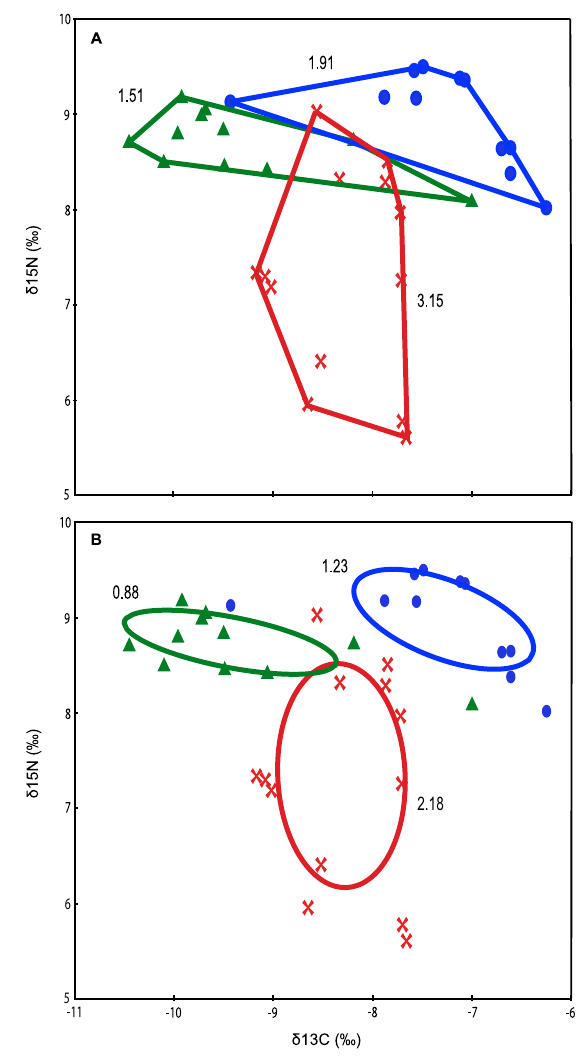
Figure 5. Bivariate plots of isotopic space depicting niche areas for muscle tissue of Dasyatis americana (red), Ginglymostoma cirratum (blue) and Carcharhinusperezi (green), using (A) convex hull areas [ 40 ] , and (B) Bayesian ellipses [ 17 ]